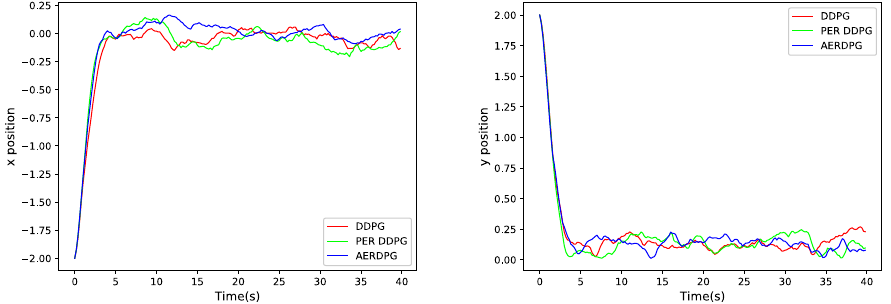
Figure 8. The control effect of AUV for various target motion probabilities.